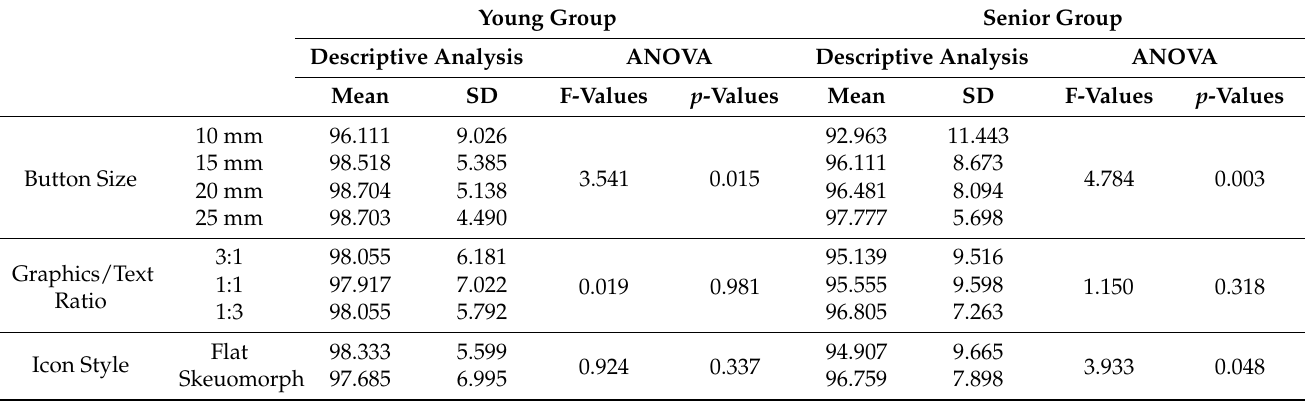
Table 2. Main effects of button size, graphics/text ratio, and icon style on task accuracy rate